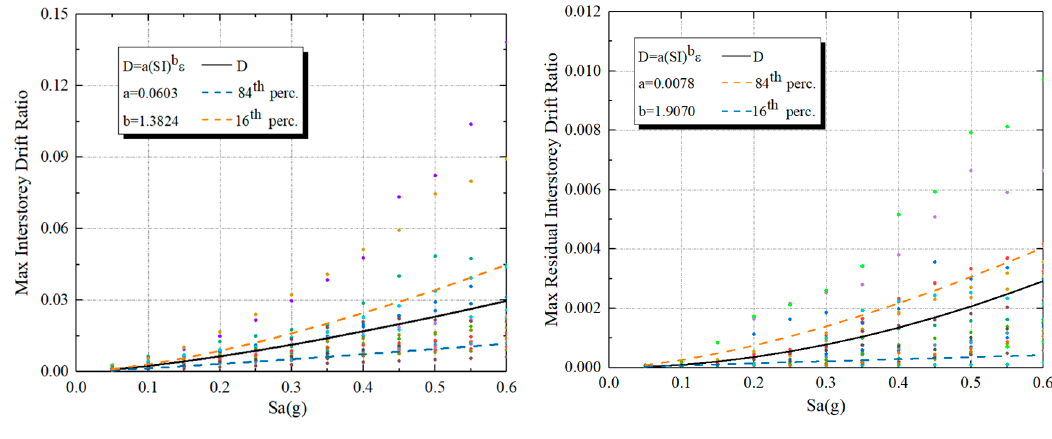
Figure 19. The IDA curves of novel SCPC frame.